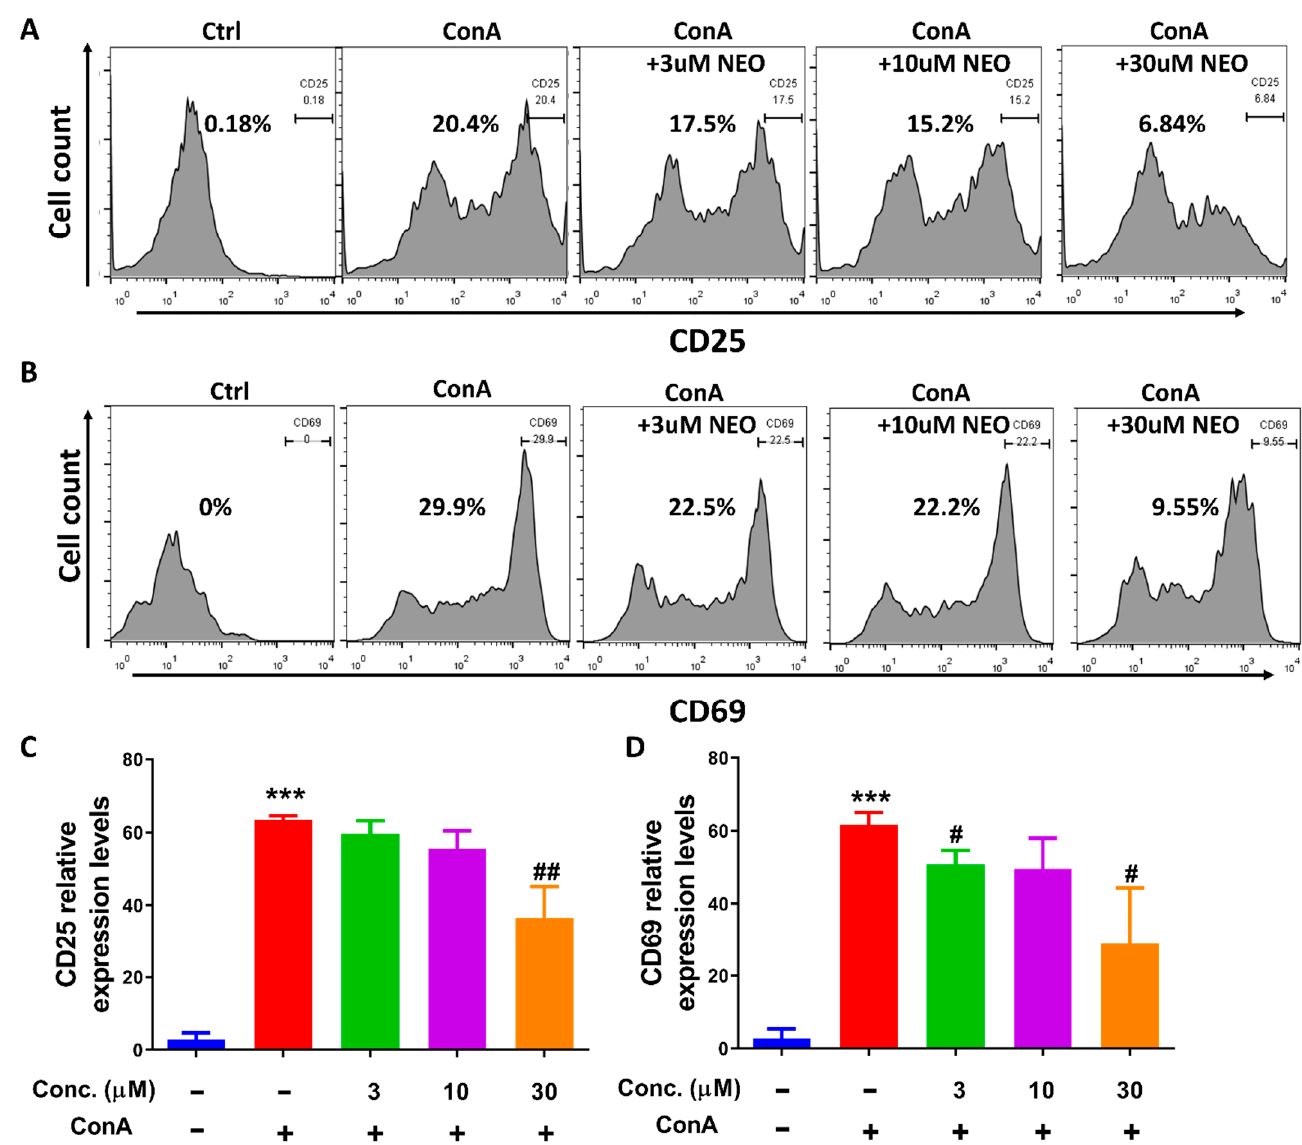
Figure 4. Effect of NEO on CD4 + T cell activation. ( A , C ) NEO suppressed CD25 expression stimulated by ConA. ( B , D ) NEO suppressed CD69 expression stimulated by ConA. The results represent three independent experiments. *** p < 0.001 indicated that the differences were statistically significant vs. control group; whereas, # p < 0.05, and ## p < 0.01 declared statistically significant differences vs. ConA-stimulated group (n = 3).